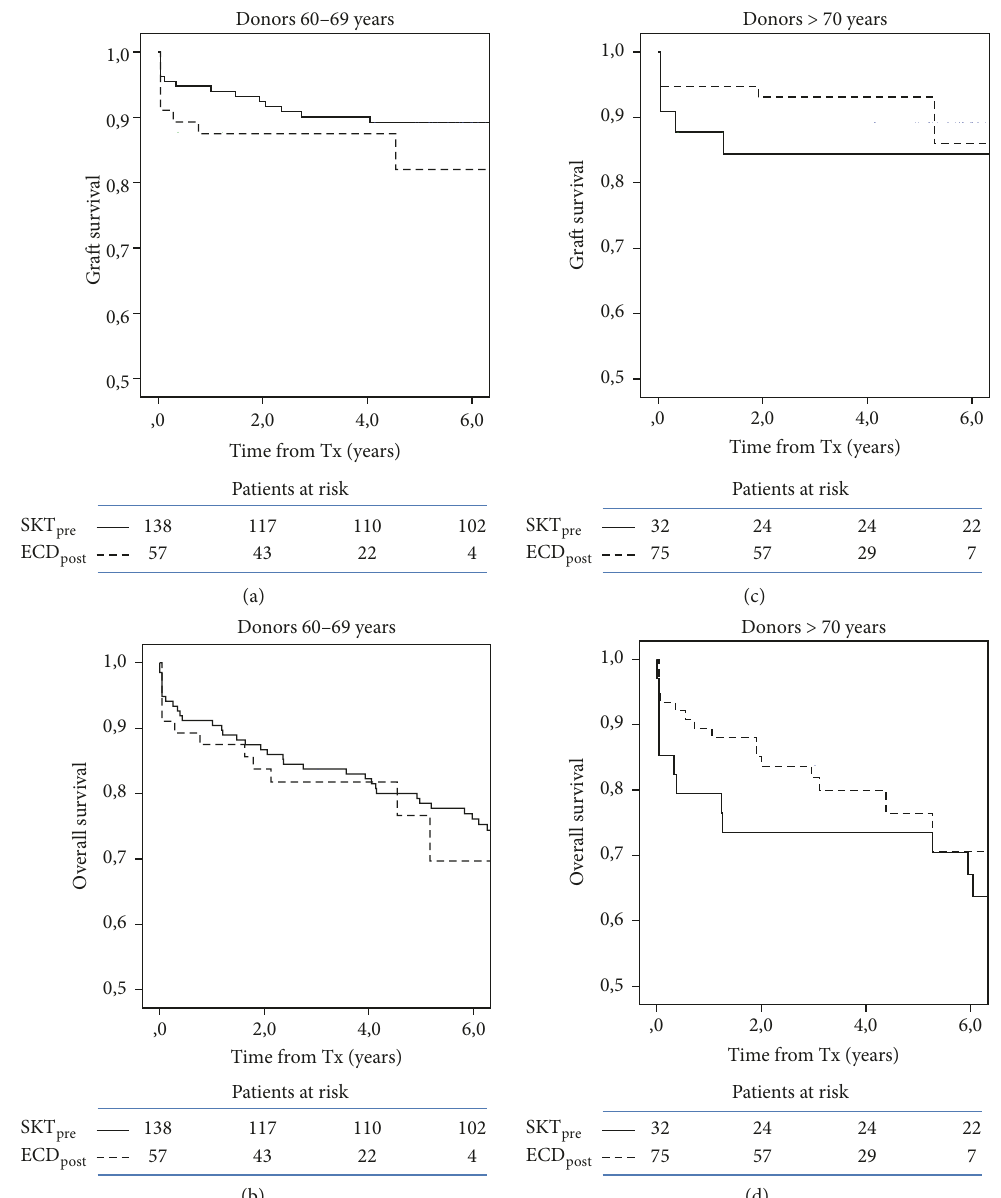
Figure 3: Kaplan-Meier plots of graft (a, c) and overall survival (b, d) in transplants from ECD according to donor age and period. ECD includes SKT (60–69 age range), SKT , and DKT (donors > 70 years). All comparisons are statistically not lr hr